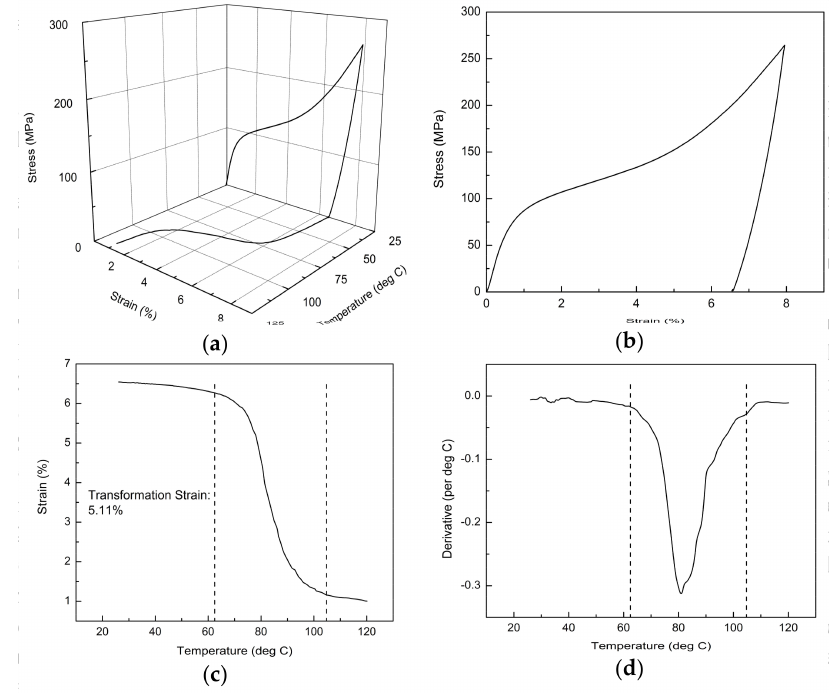
Figure 2. ( a ) Stress-strain-temperature curve of the best sample tested. The respective ( b ) stress-strain curve, ( c ) strain-temperature, and ( d ) its derivative curve are